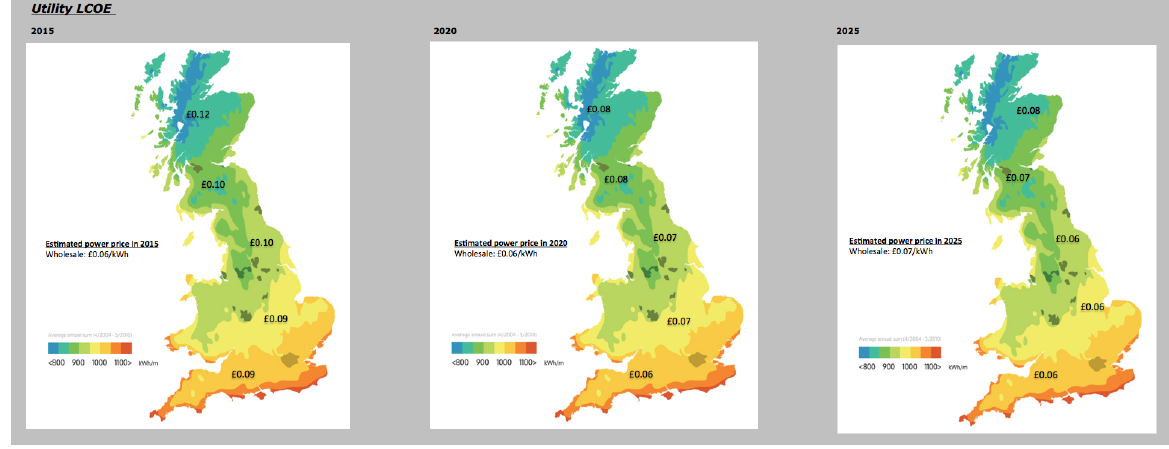
Figure 5. UK large-scale solar farm LCOEs, £/kWh, 2015–2025.